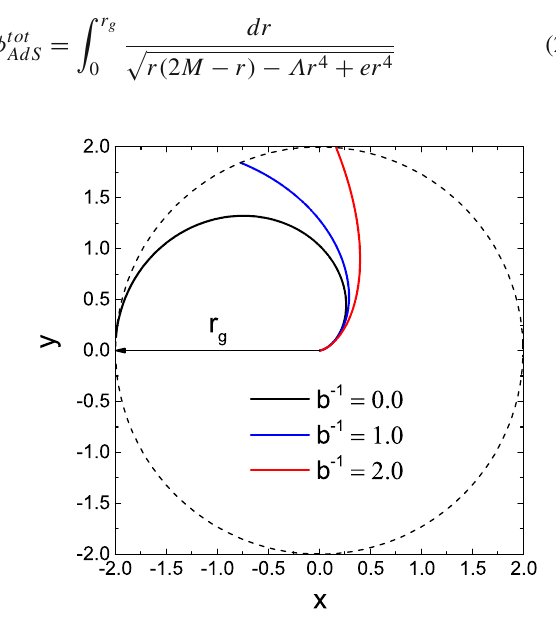
Fig. 2 Total revolution angle φ tot values of b −